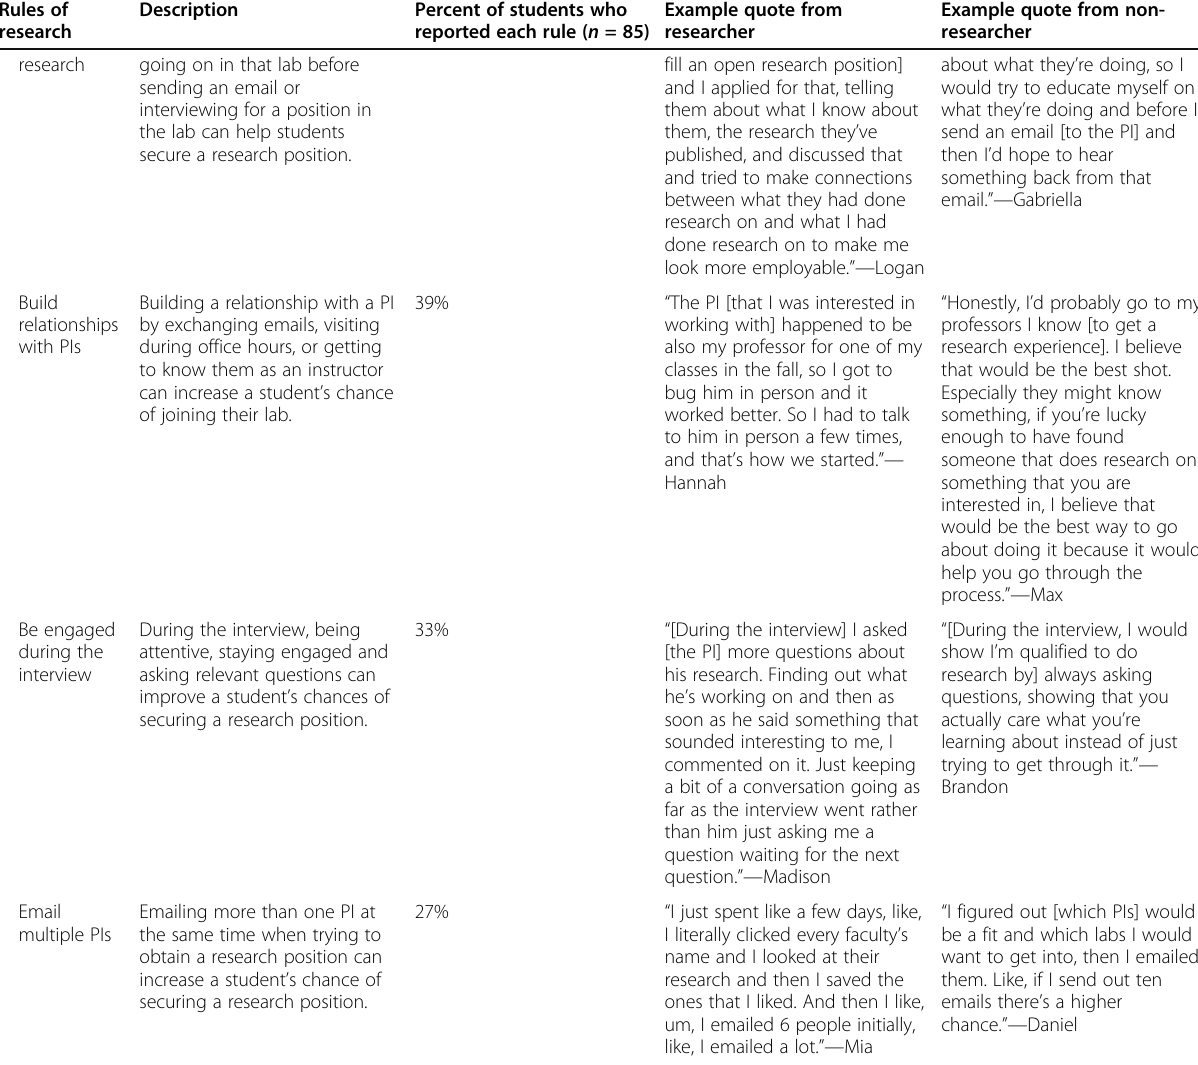
Table 2 Each rule of research described by interviewees about how to find a research experience and how to secure a research experience